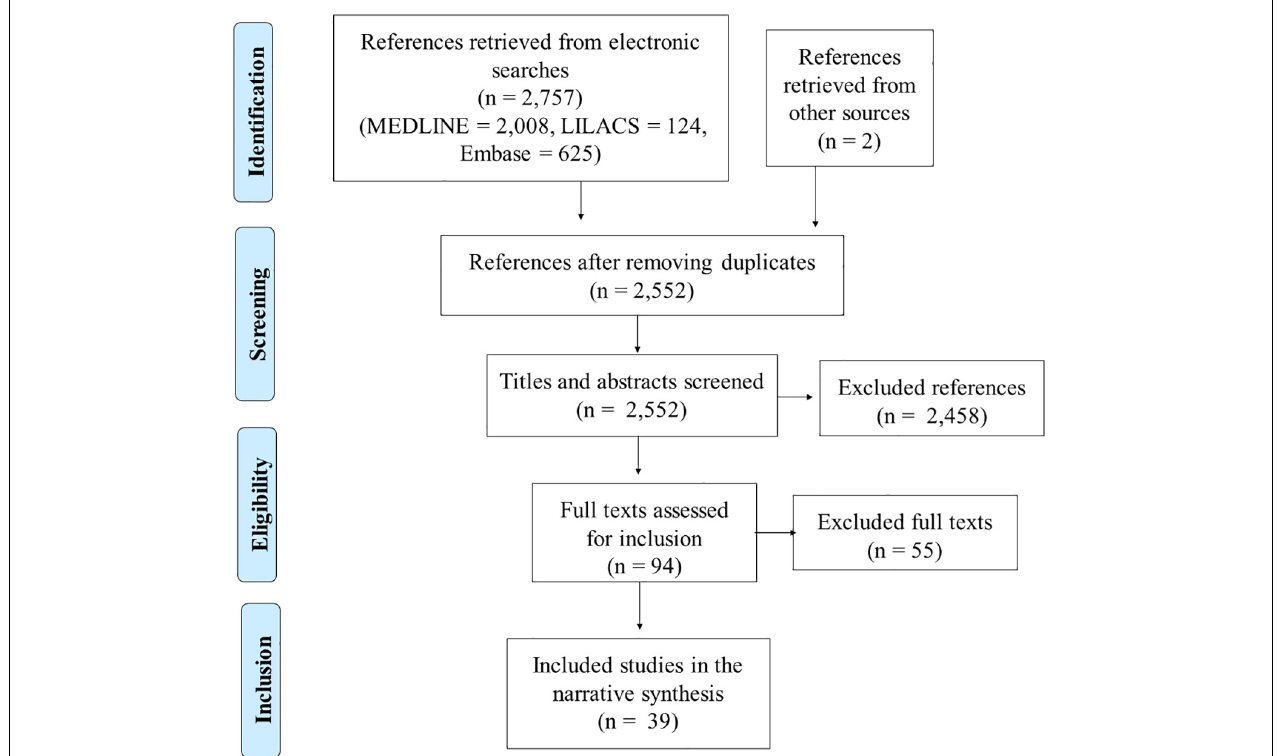
FIGURE 1 | Study flow